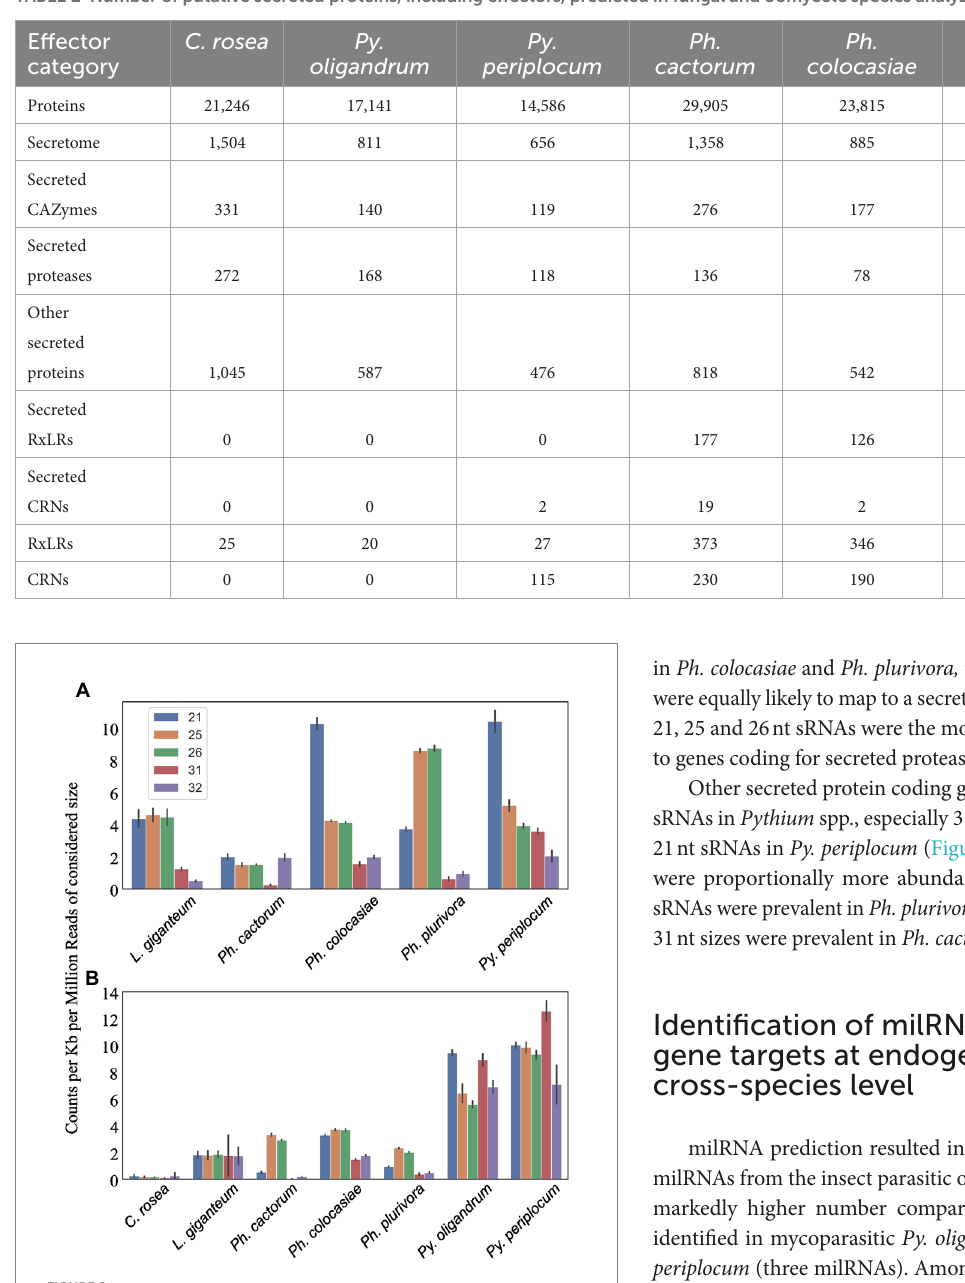
FIGURE 8 Number of sRNA reads mapping to putative effectors detected in the species of interest. Data normalized according to total kb extent of the respective effector area in the genome and to millions of reads of the specific sRNA size for the sample. Error bars indicate the standard deviation. (A) CRNs. (B)